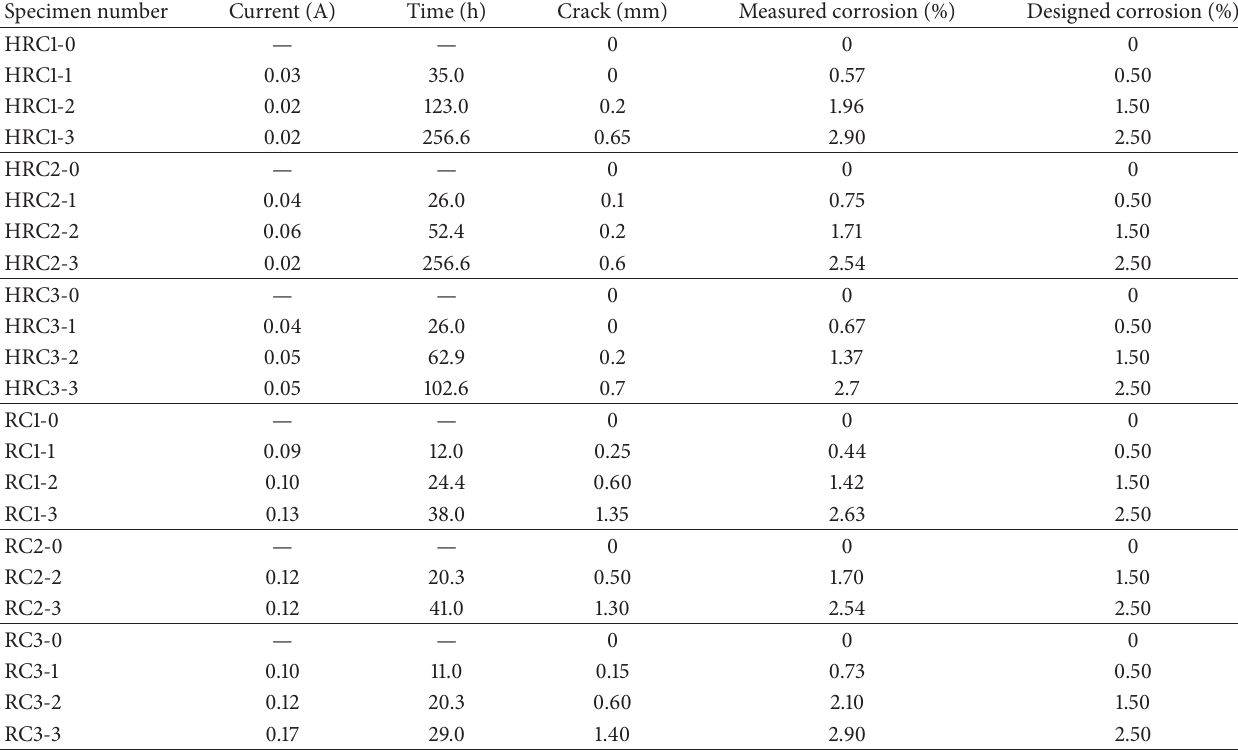
Table 3: Corrosion of different